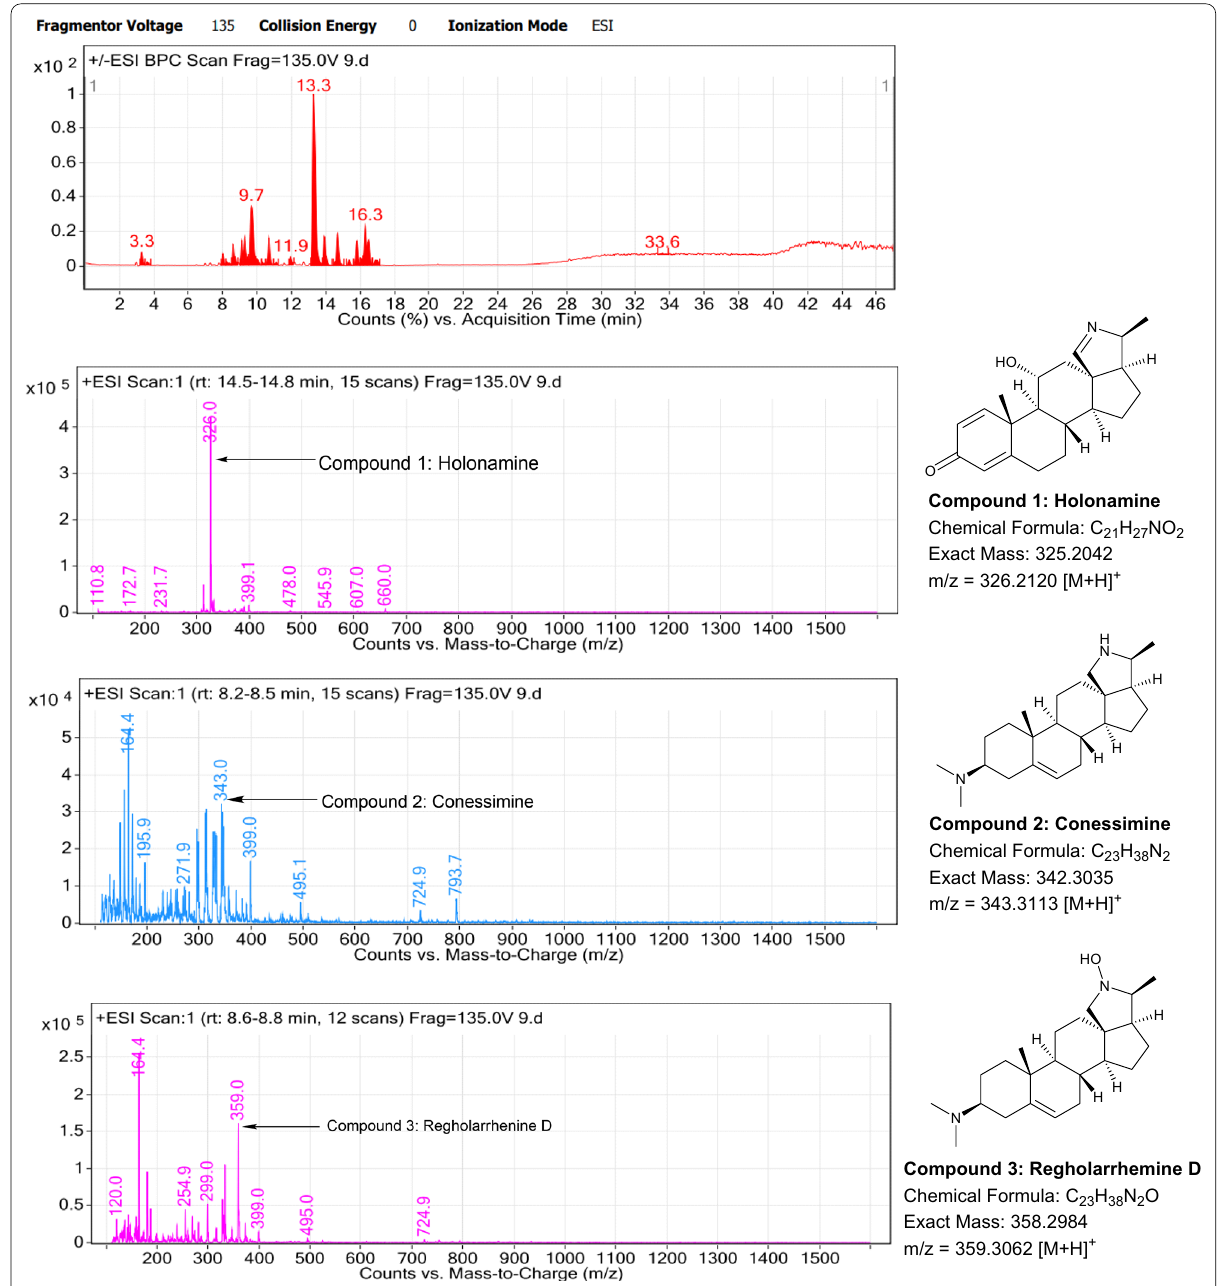
Fig. 15 LC–MS chromatogram of root extract of Holarrhena pubescens showing marker